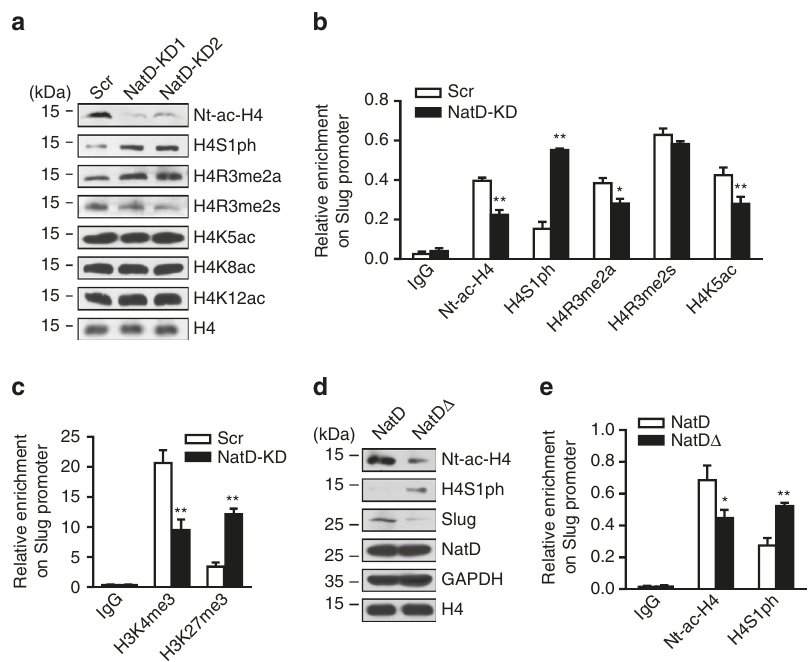
Fig. 6 Nt-acetylation of histone H4 antagonizes phosphorylation of histone H4 serine 1 to regulate Slug expression. a Western blot analysis of indicated histone H4 modi fi cations in Scr and NatD-KD H1299 cells. Histone H4 served as a loading control. b ChIP analysis of the enrichment of indicated histone H4 modi fi cations on the Slug promoter in Scr and NatD-KD H1299 cells. IgG served as a negative control. Results are shown as mean ± s.d. from three independent experiments; two-tailed Student ’ s t -test, * P < 0.05, ** P < 0.01 compared with the Scr control. c ChIP analysis of the enrichment of H3K4me3 and H3K27me3 on the Slug promoter in Scr and NatD-KD H1299 cells. IgG served as a negative control. Results are shown as mean ± s.d. from three independent experiments; two-tailed Student ’ s t -test, ** P < 0.01 compared with the Scr control. d Western blot analysis of indicated proteins from H1299 cells overexpressing NatD Δ or wild-type NatD. Histone H4 served as a loading control. e ChIP analysis of the enrichment of Nt-ac-H4 and H4S1ph on Slug promoter in H1299 cells overexpressing NatD Δ or wild-type NatD. IgG served as a negative control. Results are shown as mean ± s.d. from